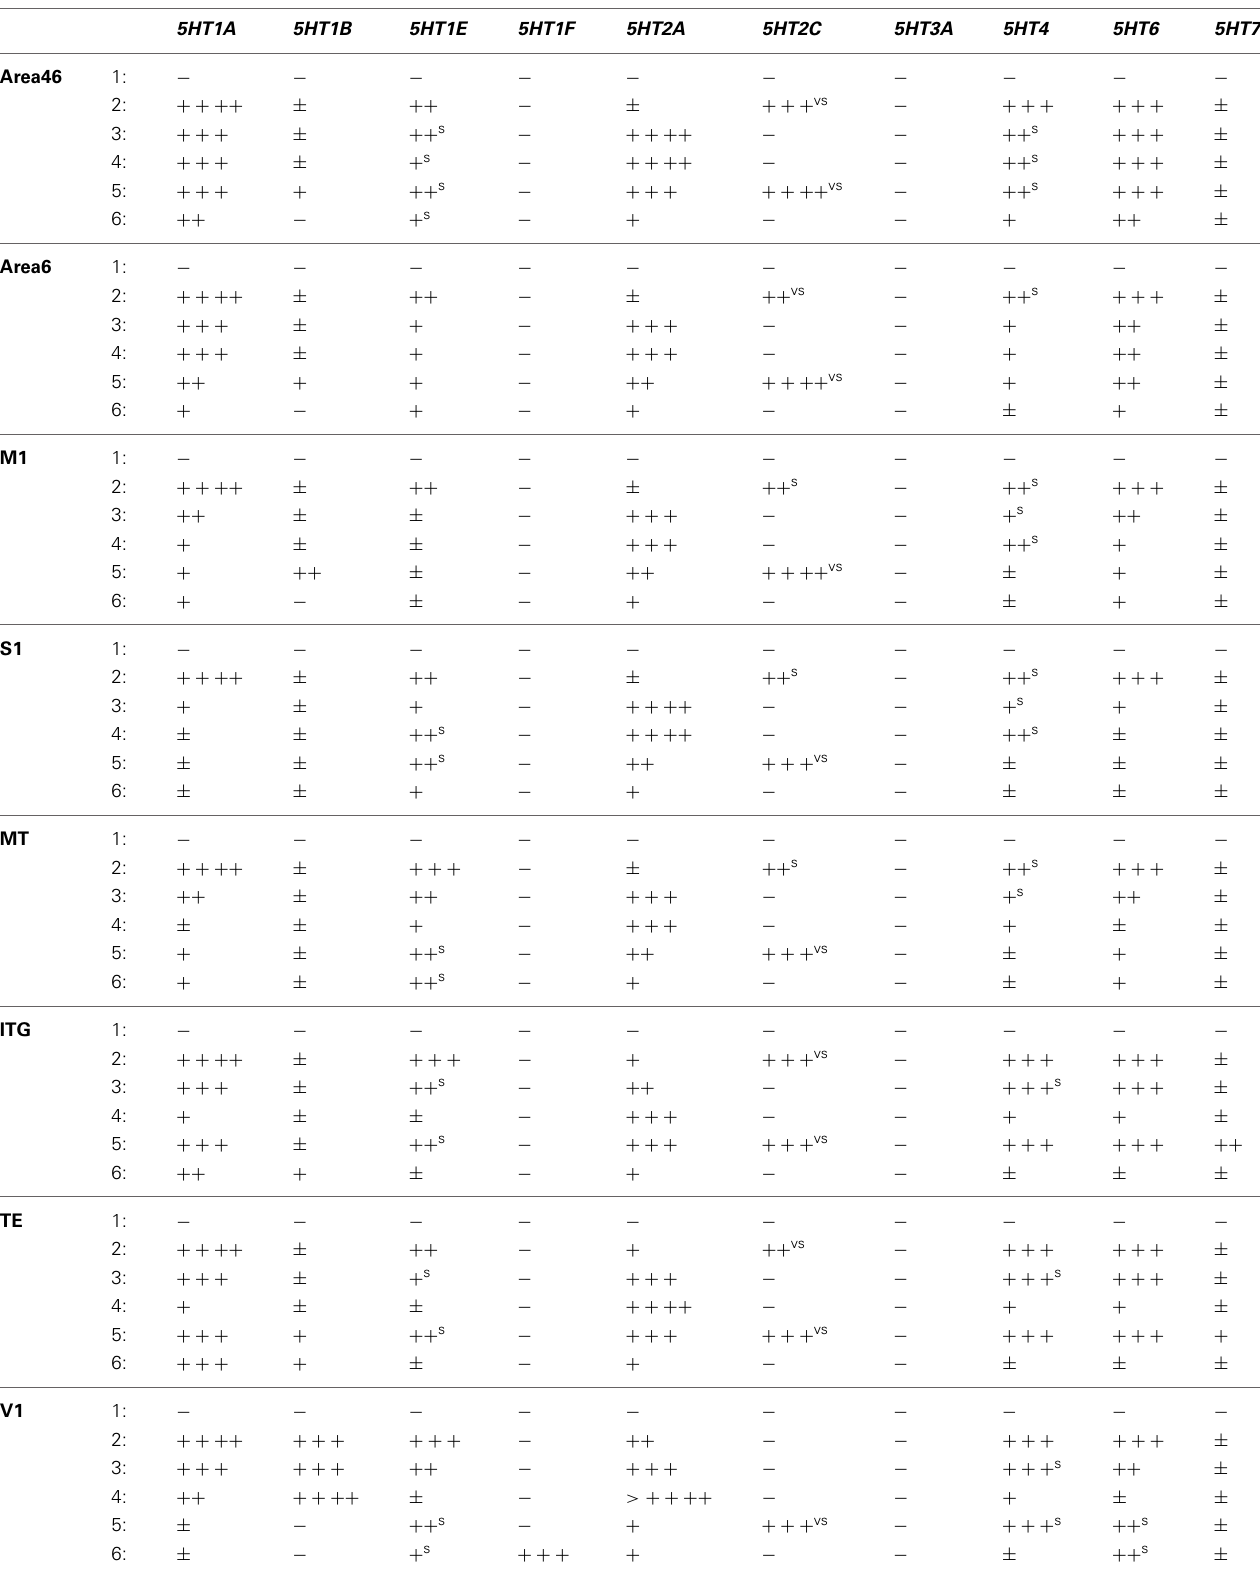
Table 2 | Arbitrary values assigned for different levels of expression in cortical brain areas. 5HT1A 5HT1B 5HT1E 5HT1F 5HT2A 5HT2C 5HT3A 5HT4 5HT6